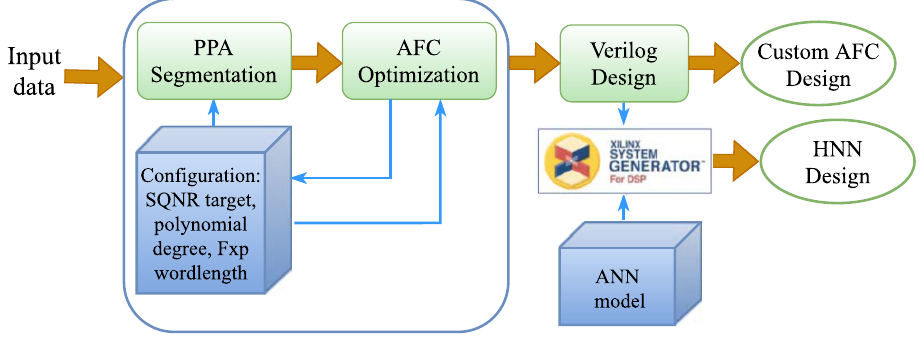
Figure 2. Design framework for implementing AFC in HNN. Table 1. Description of non-linear AFs for ANN. Mathematical AF Description